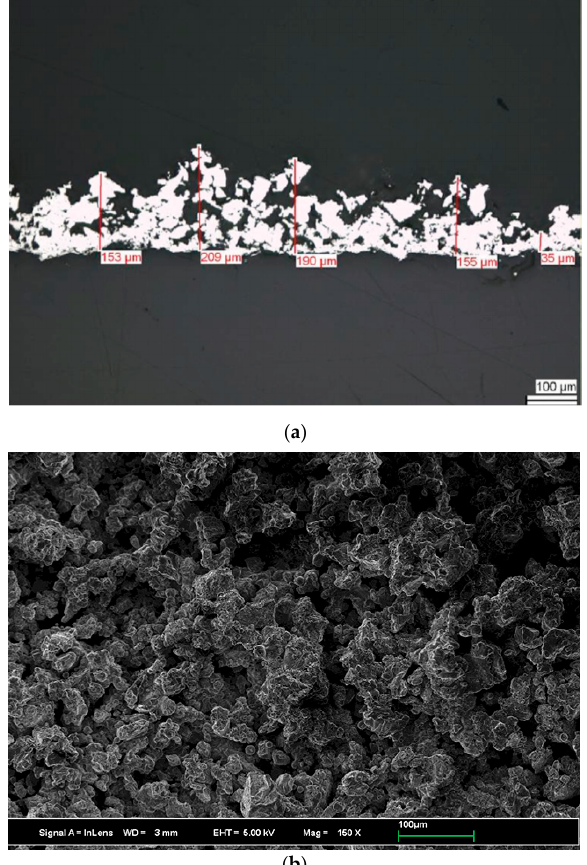
Figure 7. Scanning electron microscopic images showing ( a ) cross-sectional and ( b ) top views of porous Ti layer coated on PEEK through vacuum plasma spraying. Reproduced from [113] with permission of Dove Press under the Creative Commons Attribution – Non-Commercial (unported, v3.0) license.